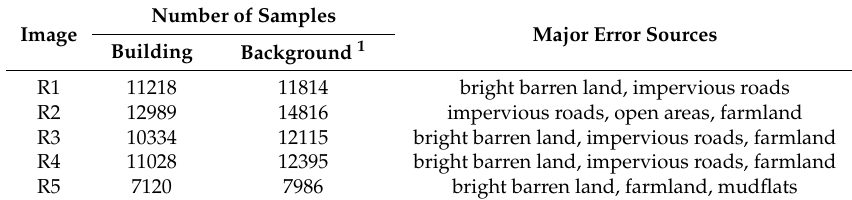
Table 3. Number of samples and major error sources for R1–R5.